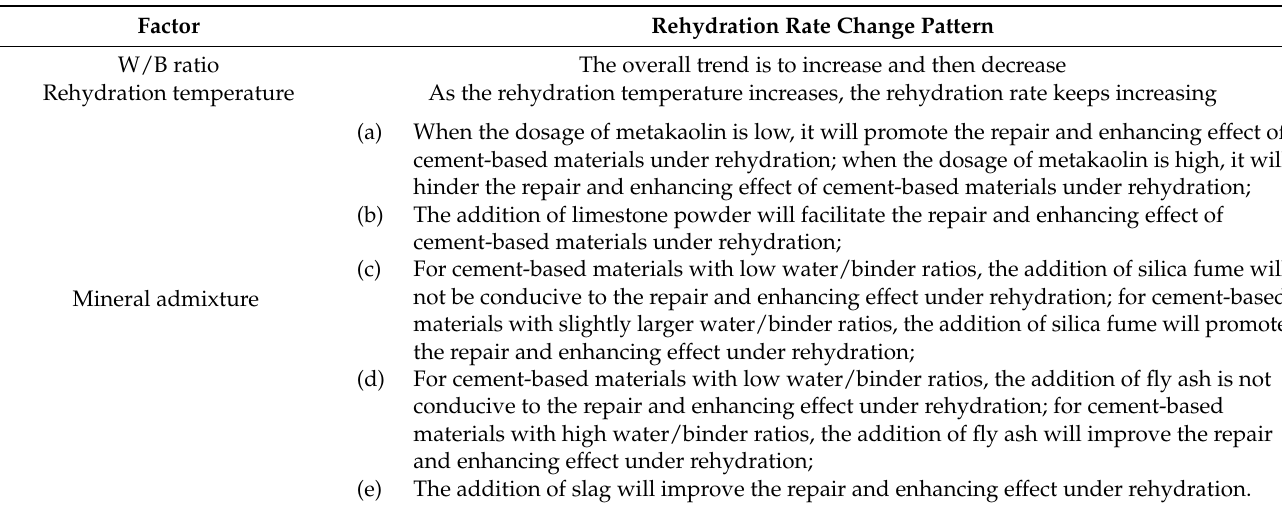
Table 4. Influence of different factors on